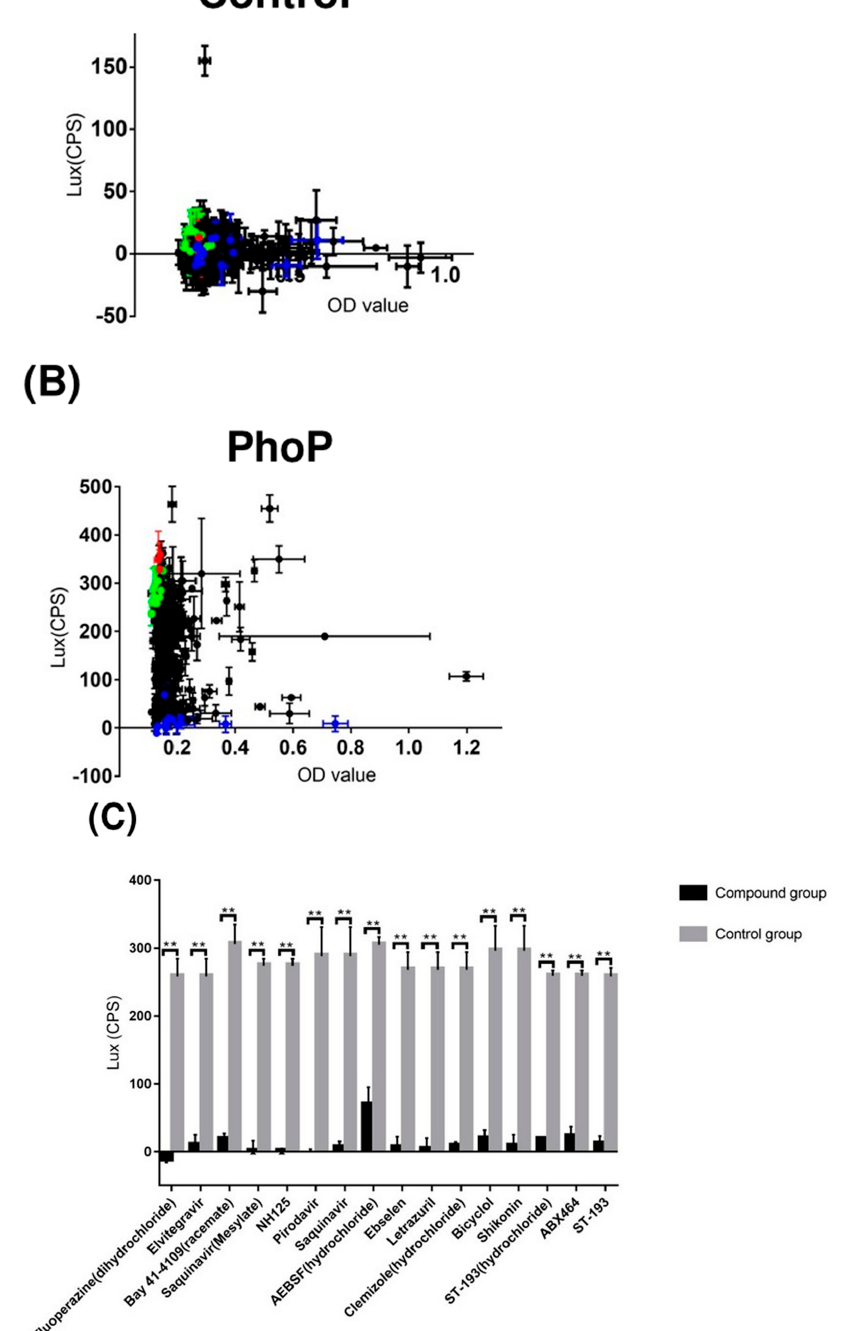
Figure 2. Screening of 320 antiviral compounds and 3 anti ‐ TB drugs. ( A ) OD 600 and LUX of all samples with/without 4 h compound treatment in negative control platform of M. bovis BCG. ( B ) OD 600 and LUX of all samples in the phoP promoter ‐ reporter platform. Green dots represent BCG samples (including pMV306Adaptor+Lux) without any compound treatment. Red dots represent samples treated with the three anti ‐ TB drugs. Blue dots represent samples treated with the 16 selected compounds, while black dots represent samples treated with other compounds. ( C ) Comparison of lux signals between the compound treatment and control samples. ** p < 0.01 .